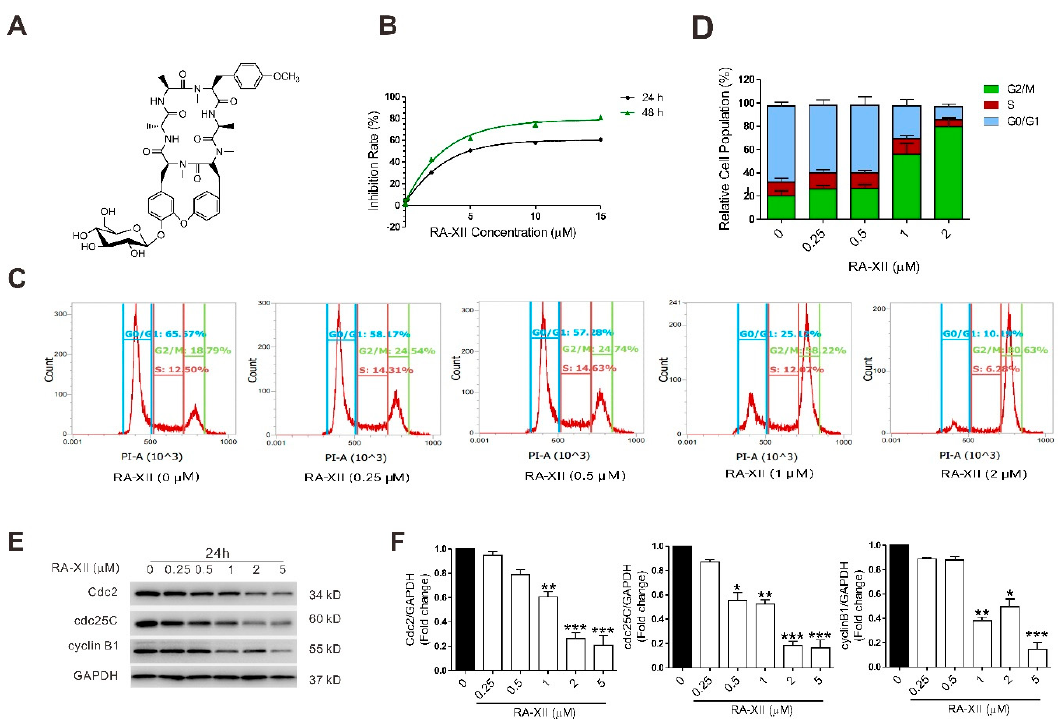
Figure 1. RA-XII induces cell death and G2 / M cell cycle arrest in HepG2 cells. ( A ) Chemical structure of RA-XII. ( B ) Sulforhodamine B (SRB) measurement of cell vitality. ( C ) Flow cytometry of cell cycle distributions. ( D ) Statistical graph of cell cycle distributions. ( E ) Protein expression of Cdc2, cdc25C, and cyclin B1. ( F ) Statistical graphs of protein expression. Cells were treated with different concentrations of RA-XII for 24 h. Results are means ± SEM of three independent experiments. * p < 0.05, ** p < 0.01, *** p < 0.001, compared with 0 μ M.